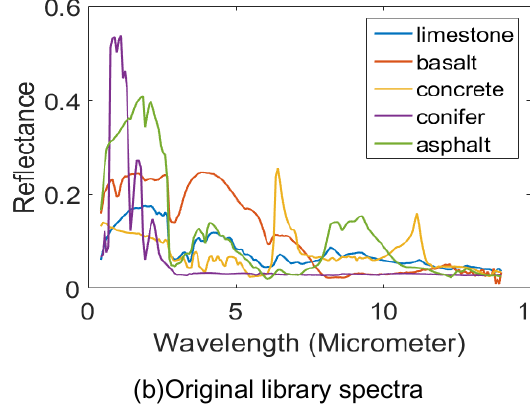
Figure 2. ( a ) The color images of the synthetic dataset. ( b ) The spectral of the endmember seeds used to construct the synthetic dataset, which is all extracted from the ASTER library.